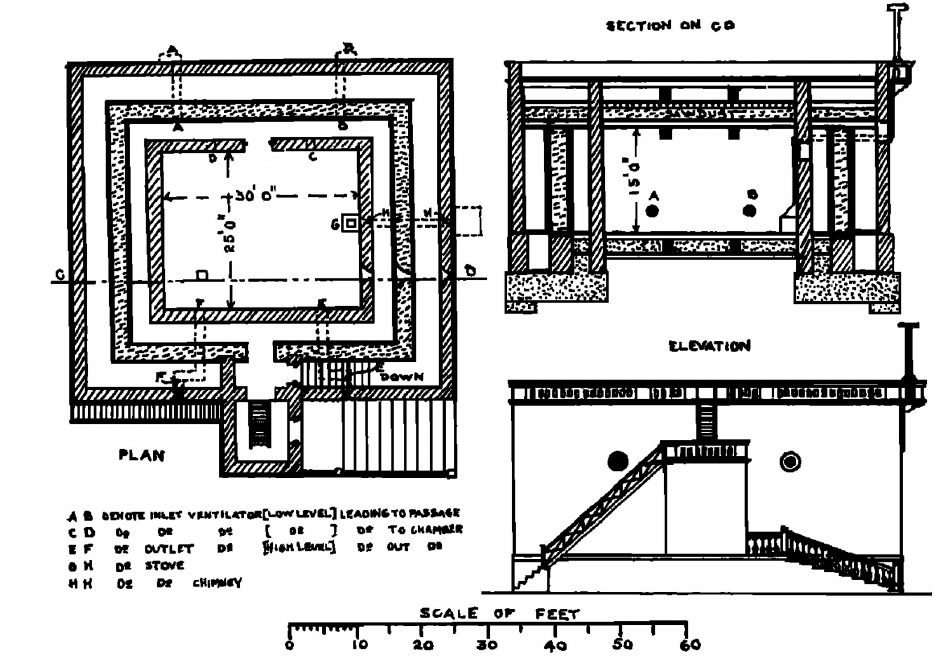
Figure 19. Plan for the overground magnetograph building at Alibag (Moos, 1912). This was the variometer room. The plan given on the left is that of the variometer room. The walls were separated by a distance of 3ft. The thick black lines denote wooden planks between which sawdust was stuffed for uniform temperature. The walls were made from Porbunder sandstone and each and every block of this rock was personally tested by Moos to make sure the observatory was nonmagnetic in